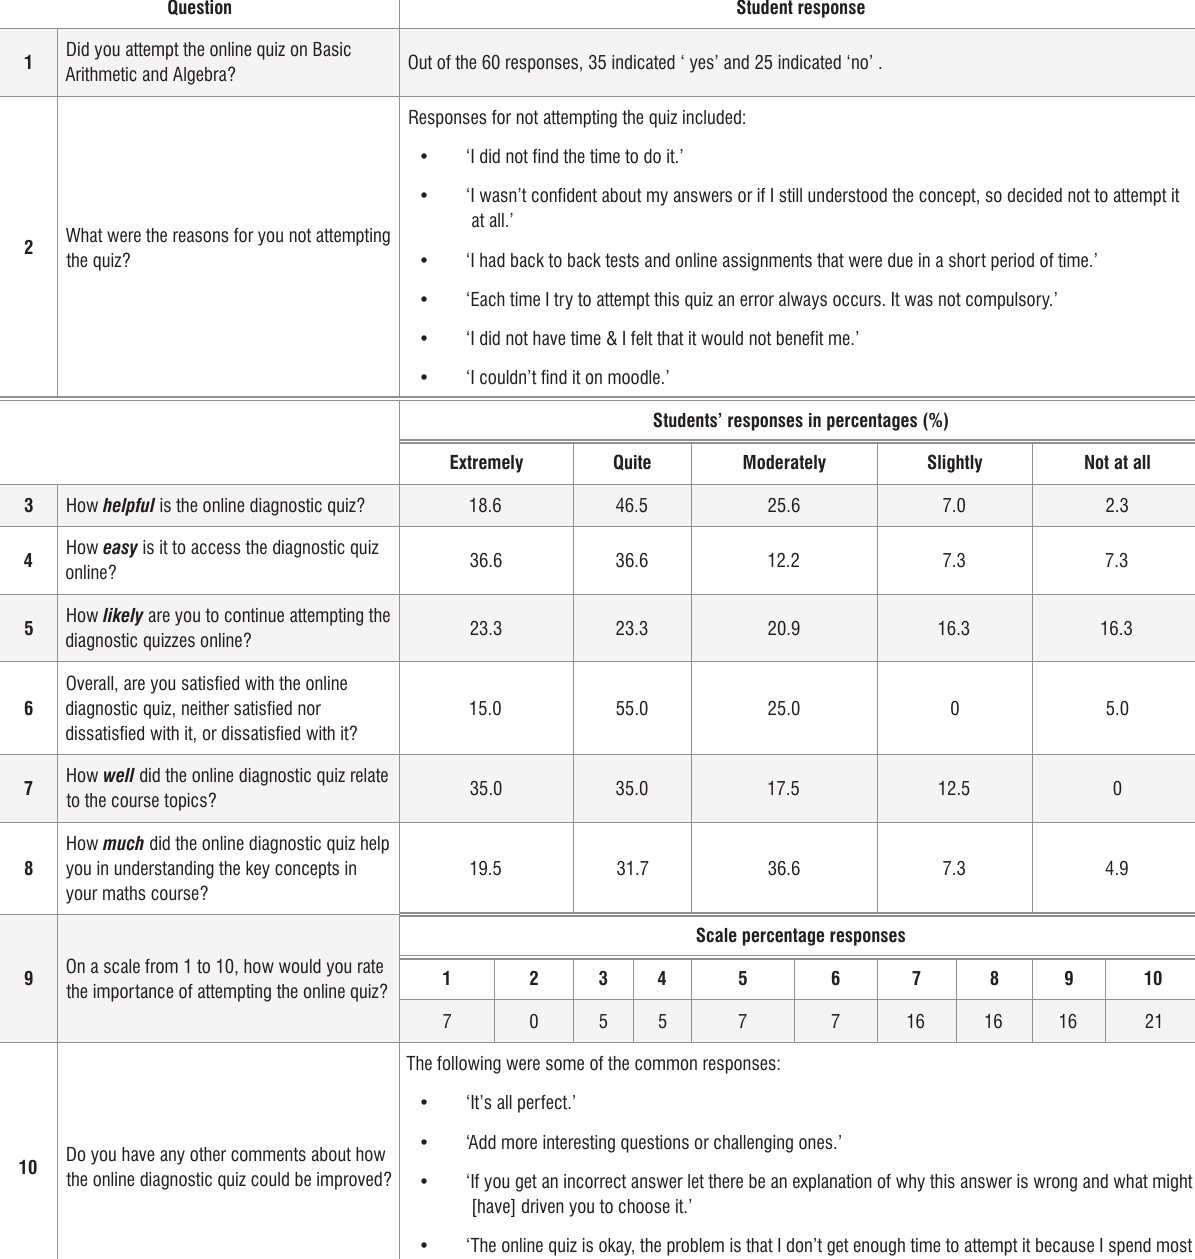
Summary of questions and responses from students ( n =60) Question Student